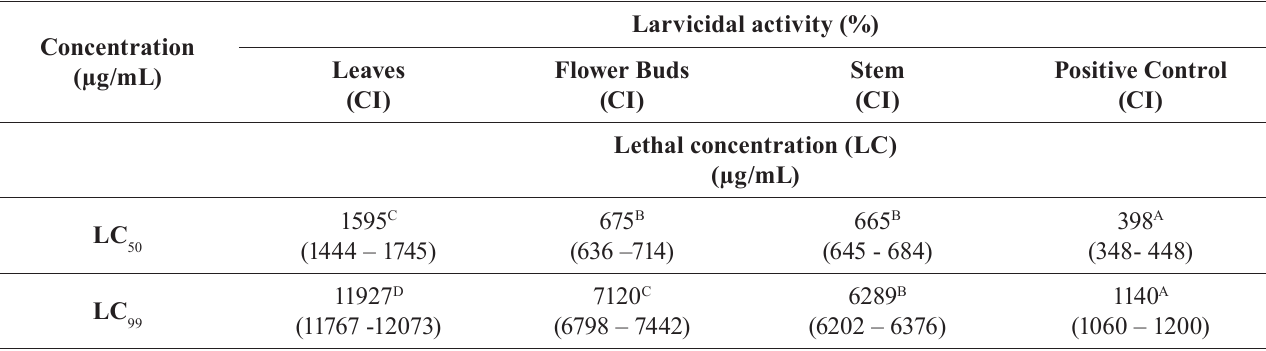
Values presented with average ± standard deviation. Averages followed by same letters in the same column and lines do not statistically differ by Tukey test with significance level of 5%. Different lowercase letters in